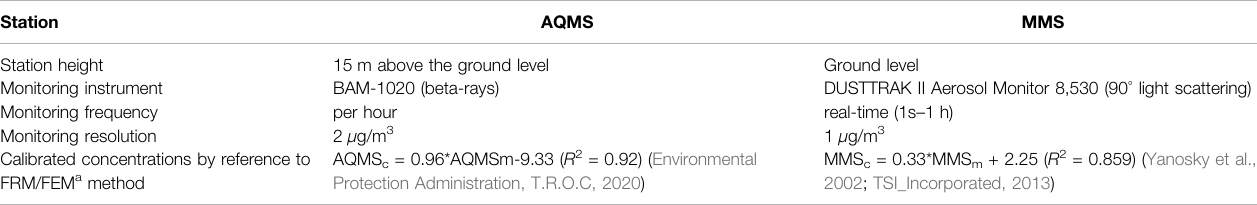
TABLE 1 | Basic information for the AQMS and MMS used in the present study for measuring PM 2.5 concentrations. Station AQMS Station